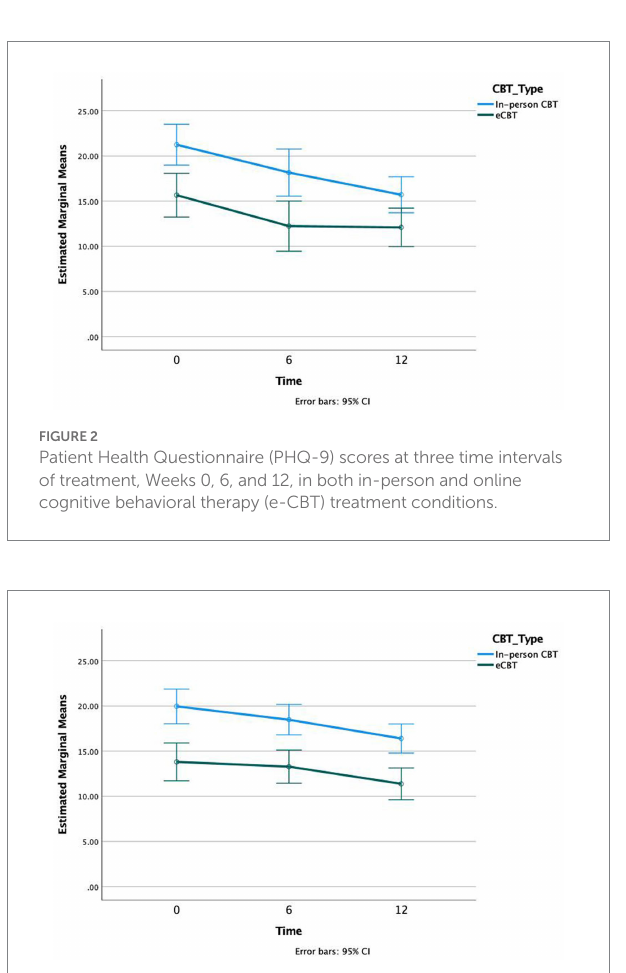
FIGURE 3 Quick Inventory of Depressive Symptomatology (QIDS-SR) scores at three time intervals of treatment, Weeks 0, 6, and 12, in both in- person and e-CBT treatment conditions.